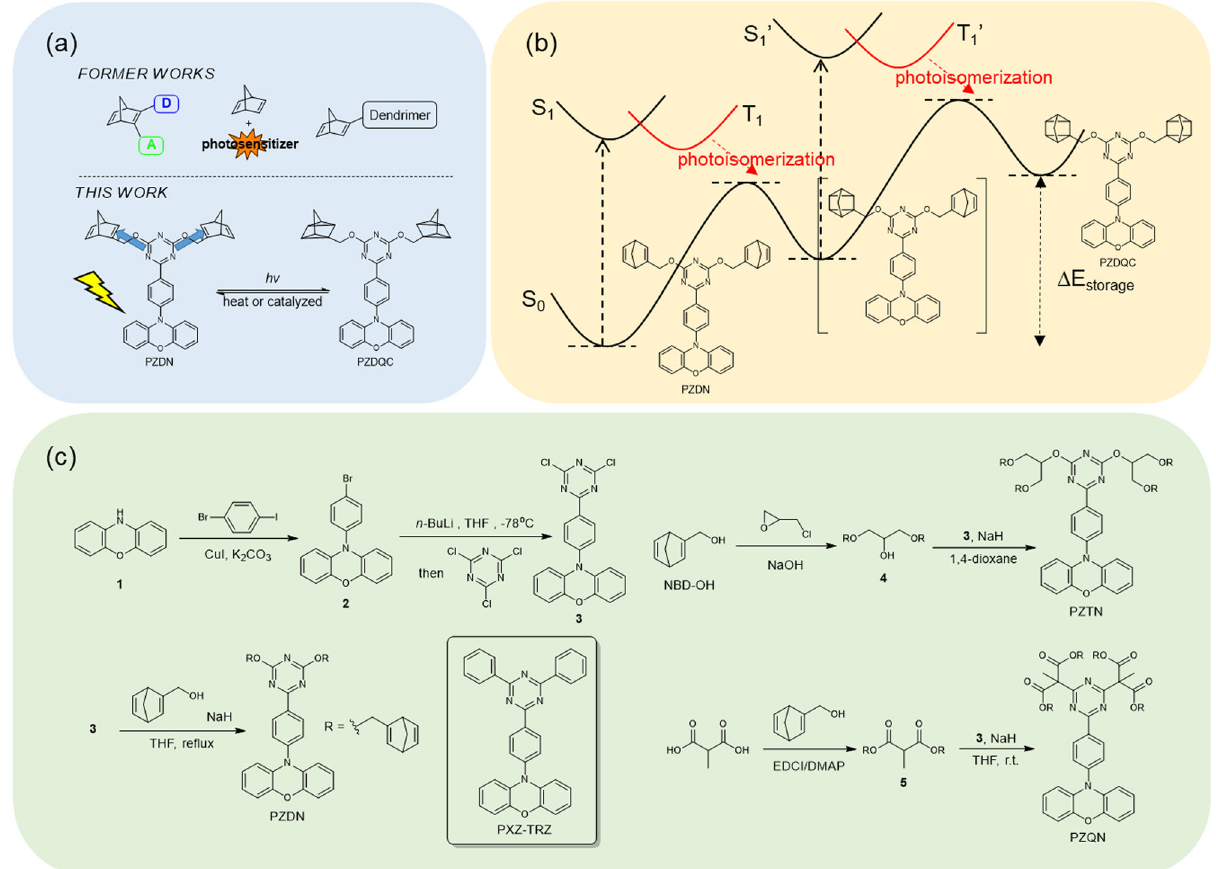
Fig. 1 Recent developments in norbornadiene for energy storage and a novel concept in this work. a Designed strategies to promote the ef fi ciency of the MOST process in the NBD-QC system. b The proposed energy pro fi le for the photochemical reaction of the PZDN-PZDQC process. c The synthetic route of PZDN, PZTN, and PZQN. Details of the reaction are provided in the supporting